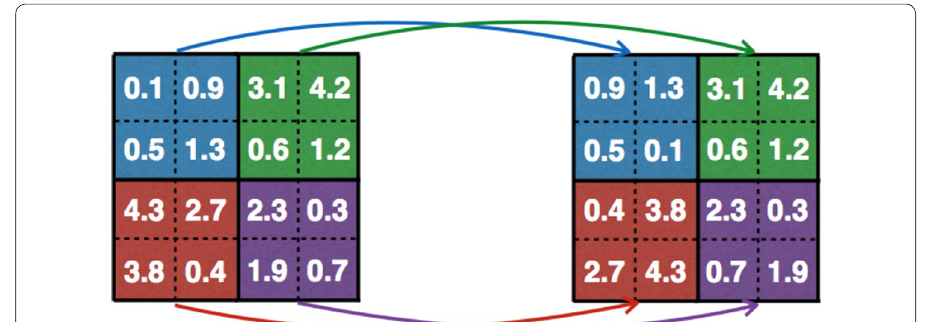
Fig. 5 Examples of applying the PatchShuffle regularization technique [64]